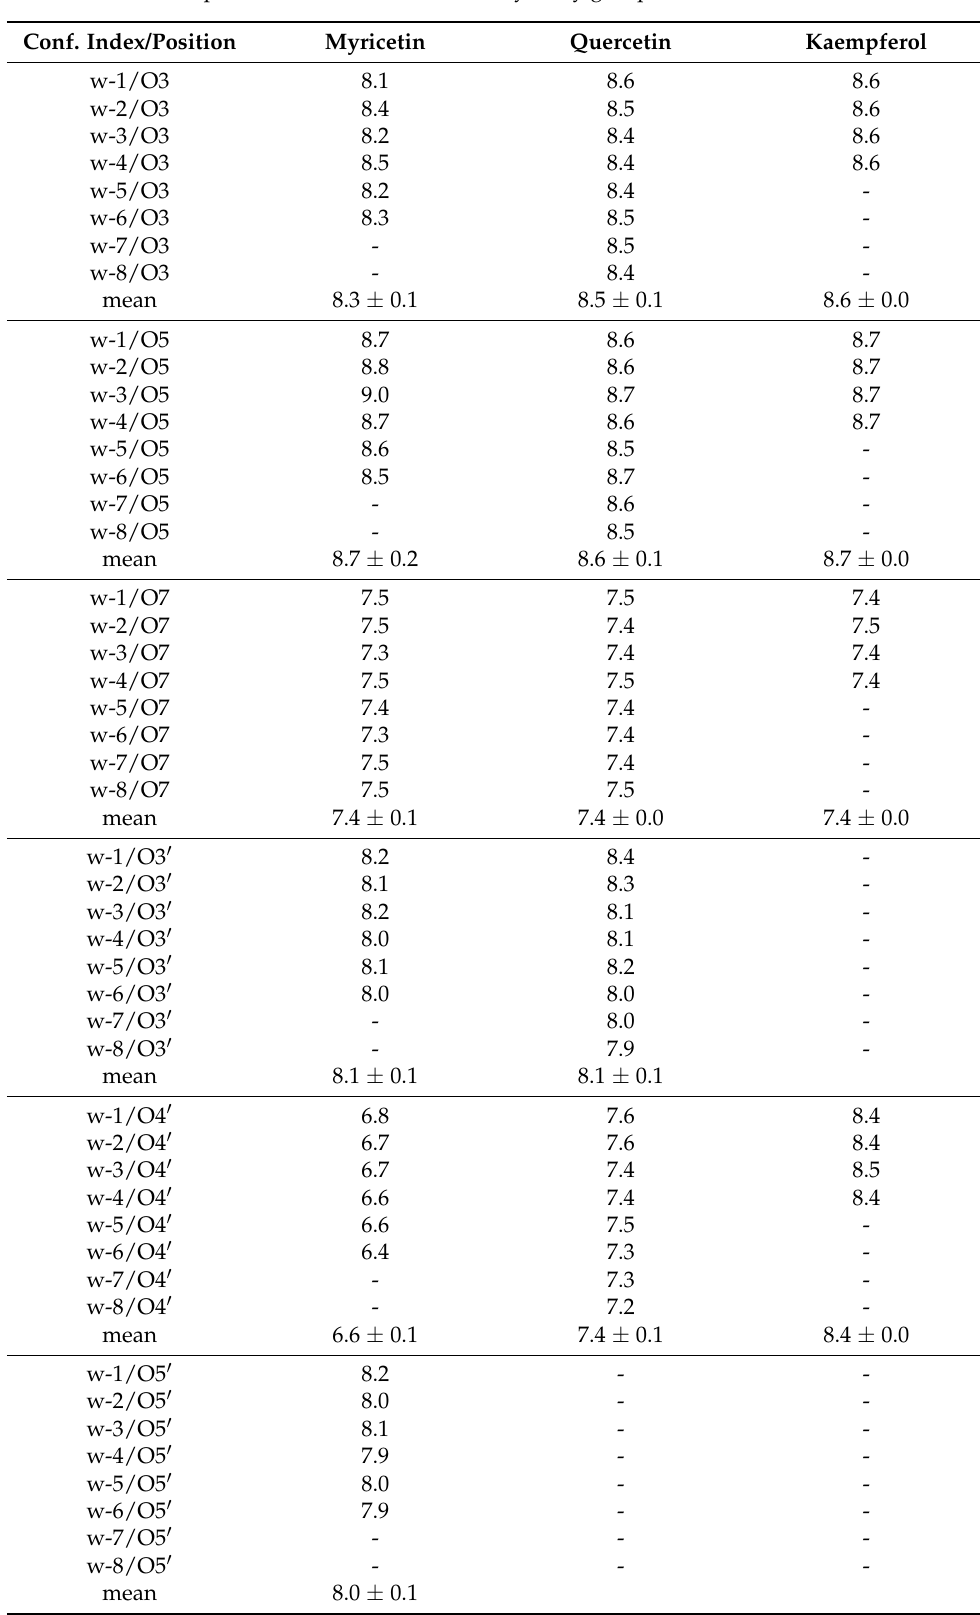
Table 5. Calculated p K a for the O-H bond in each hydroxy